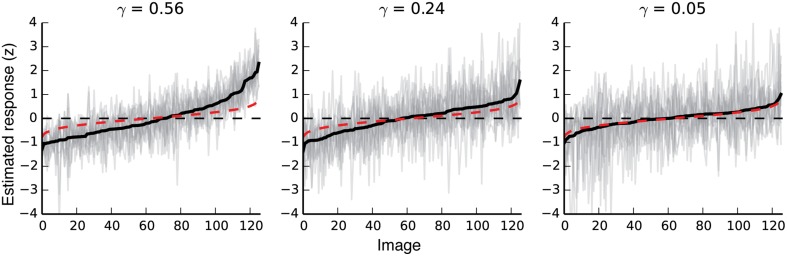
Response variability in voxels with different noise ceilings. The three plots show responses to all validation images for three different voxels with noise ceilings that are relatively high, moderate, and just above chance. The far-right plot shows the response variability for a voxel that meets our minimum criterion for inclusion in further analyses. Black lines show the mean response to each validation image. For each plot, images are sorted left to right by the average estimated response for that voxel. The 11 gray lines in each plot show 11 separate estimates of response amplitude per image for each voxel. Red dotted lines show random responses (averages of 11 random Gaussian vectors sorted by the mean of the 11 random vectors). Note that even random responses will deviate slightly from zero at the high and low ends, due to the bias induced by sorting the responses by their mean.